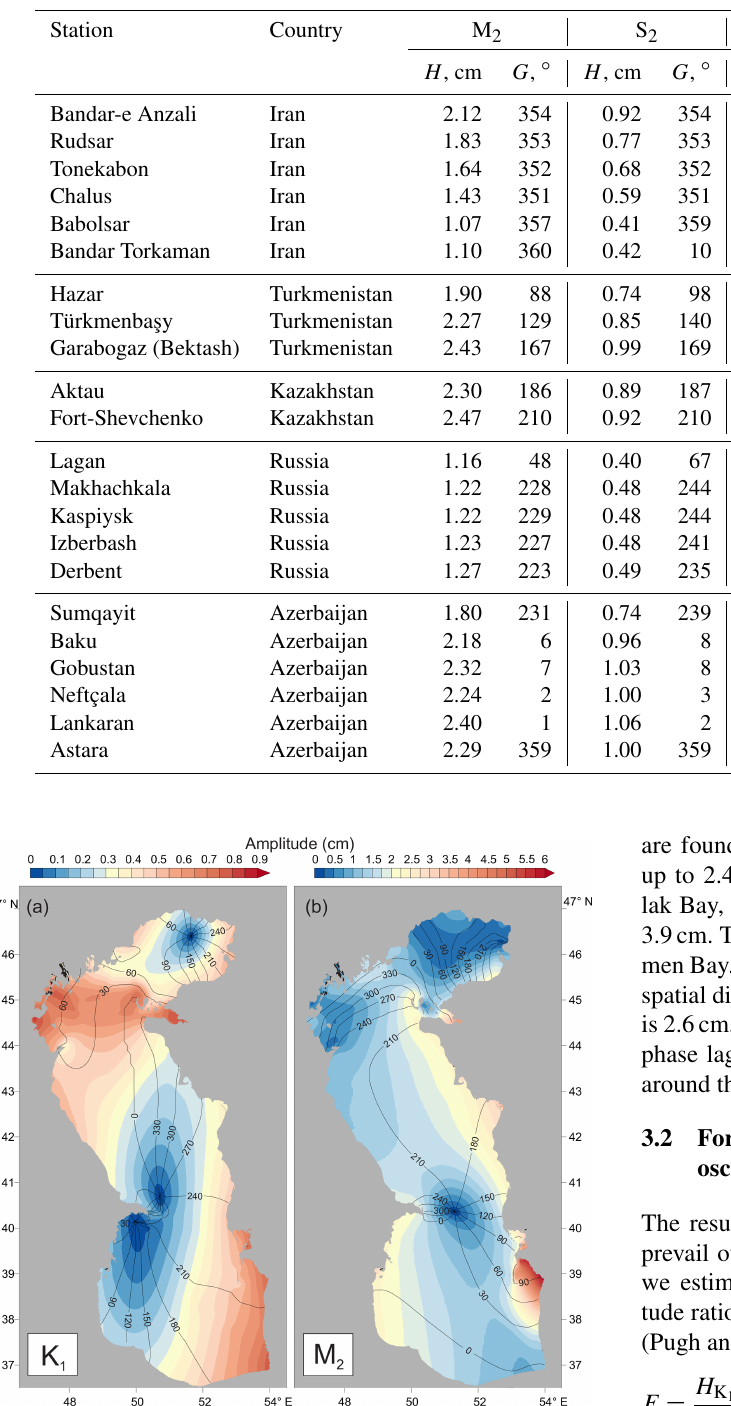
Table 2. Amplitudes ( H ) and Greenwich phase lags ( G ) of the major tidal constituents, form factor ( F ), and maximum tidal range ( R ) at the main cities in the Caspian Sea.